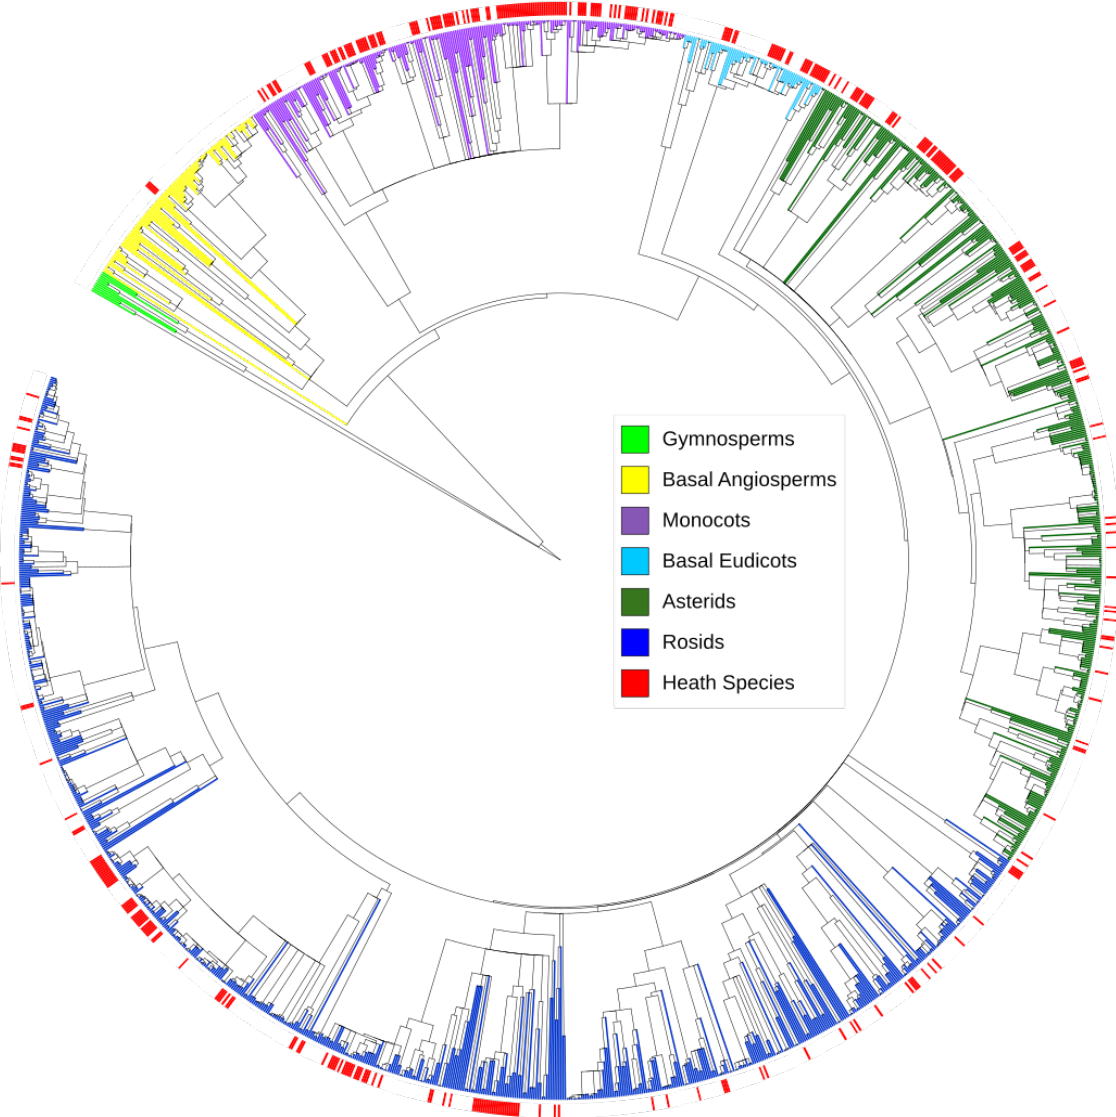
Figure 2. Phylogenetic position of the Sunshine Coast heath species (indicated in red) within the wider south-east Queensland and central Queensland rainforest phylogeny.